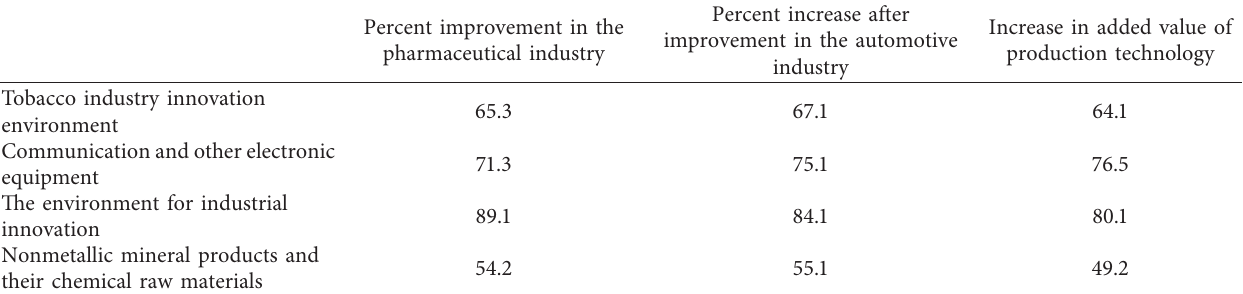
Table 2: Code and its weight of every part.